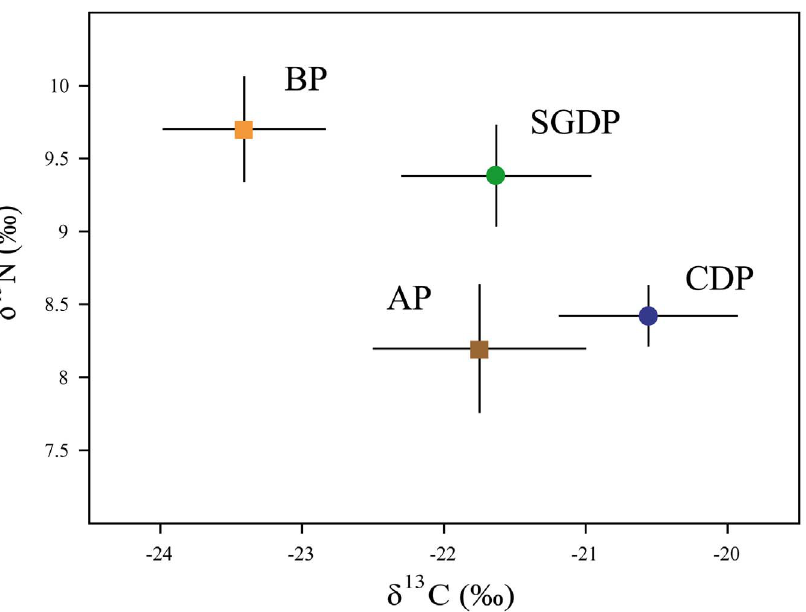
Figure 9. Isotopic niche differences. Mean 6 SD of d 15 N and d 13 C values in red cells of four species of small petrel sampled during incubation at Bird Island, South Georgia in summer 2010/11. Species abbreviations: AP (Antarctic prion), BP (blue petrel), CDP (common diving petrel) and SGDP (South Georgian diving petrel). All n=15.